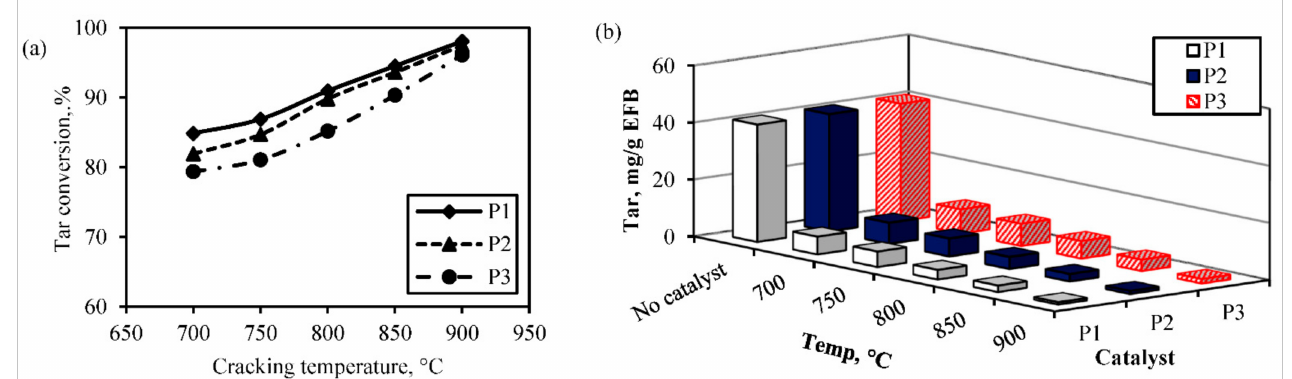
Figure 6. Effect of different catalyst to biomass (C/B) ratio on ( a ) tar conversion ( b ) tar yield.